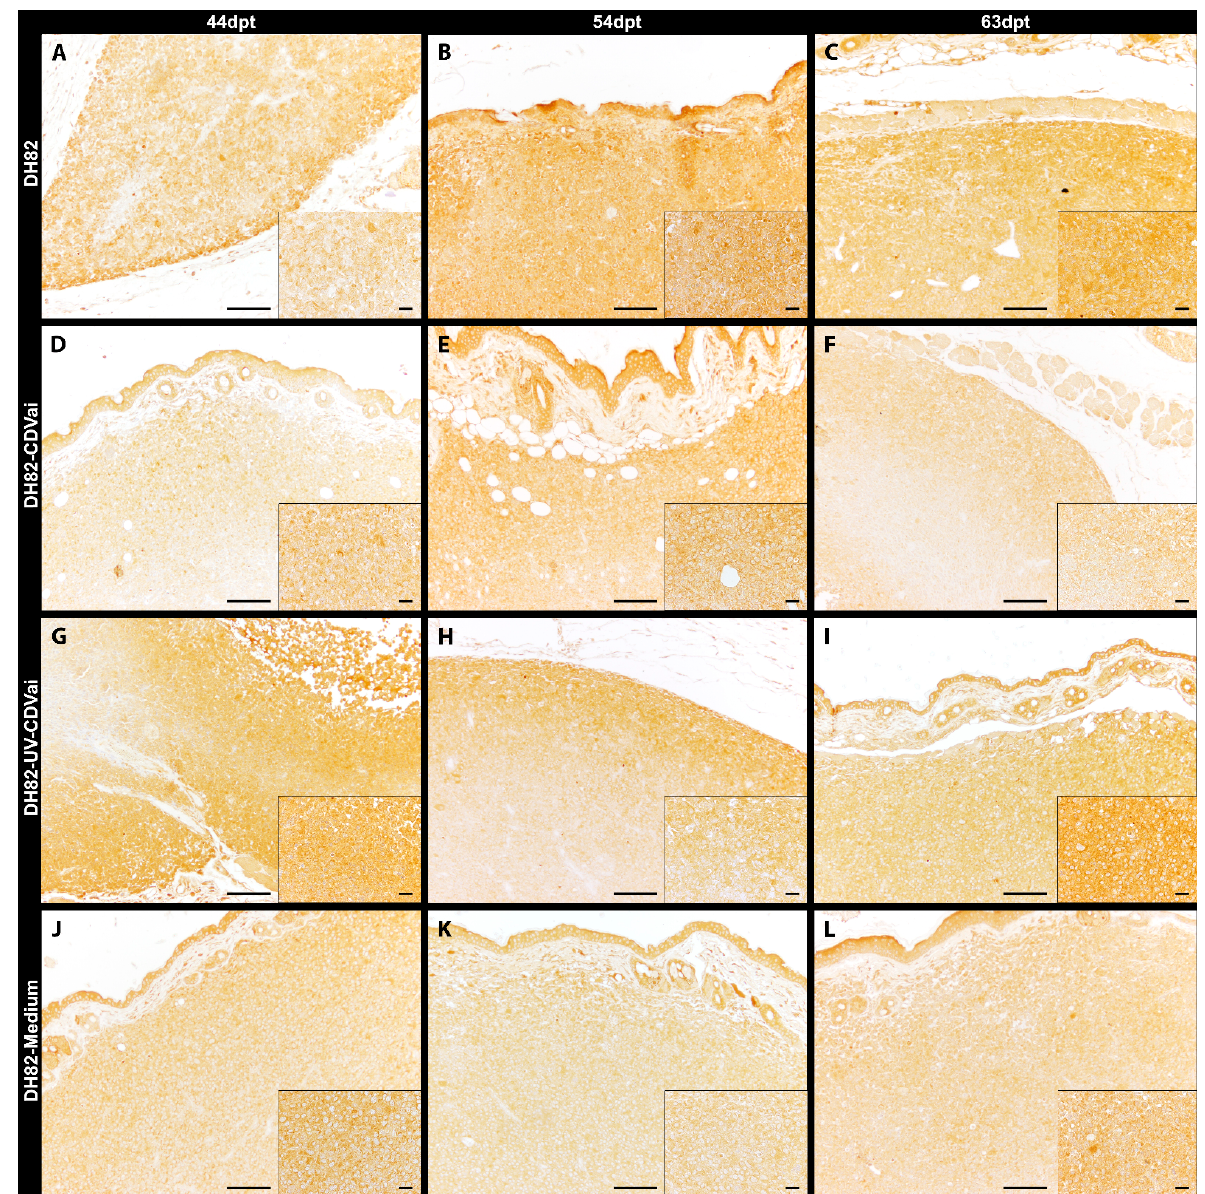
Figure 7. Peripheral MMP-14 immunolabeling in murine subcutaneous DH82 cell xenografts ( A – L ). ( A – C ) display non- infected (DH82), ( D – F ) intratumorally canine distemper virus (CDV)-infected (DH82-CDVai), ( G – I ) intratumorally UV- inactivated CDV-injected (DH82-UV-CDVai) and ( J – L ) intratumorally medium-injected (DH82-medium) neoplasms at ( A , D , G , J ) 44 days post-transplantation (dpt), ( B , E , H , K ) 54 dpt and ( C , F , I , L ) 63 dpt. Scale bar = 100 μ m and scale bar— insert = 20 μ m.